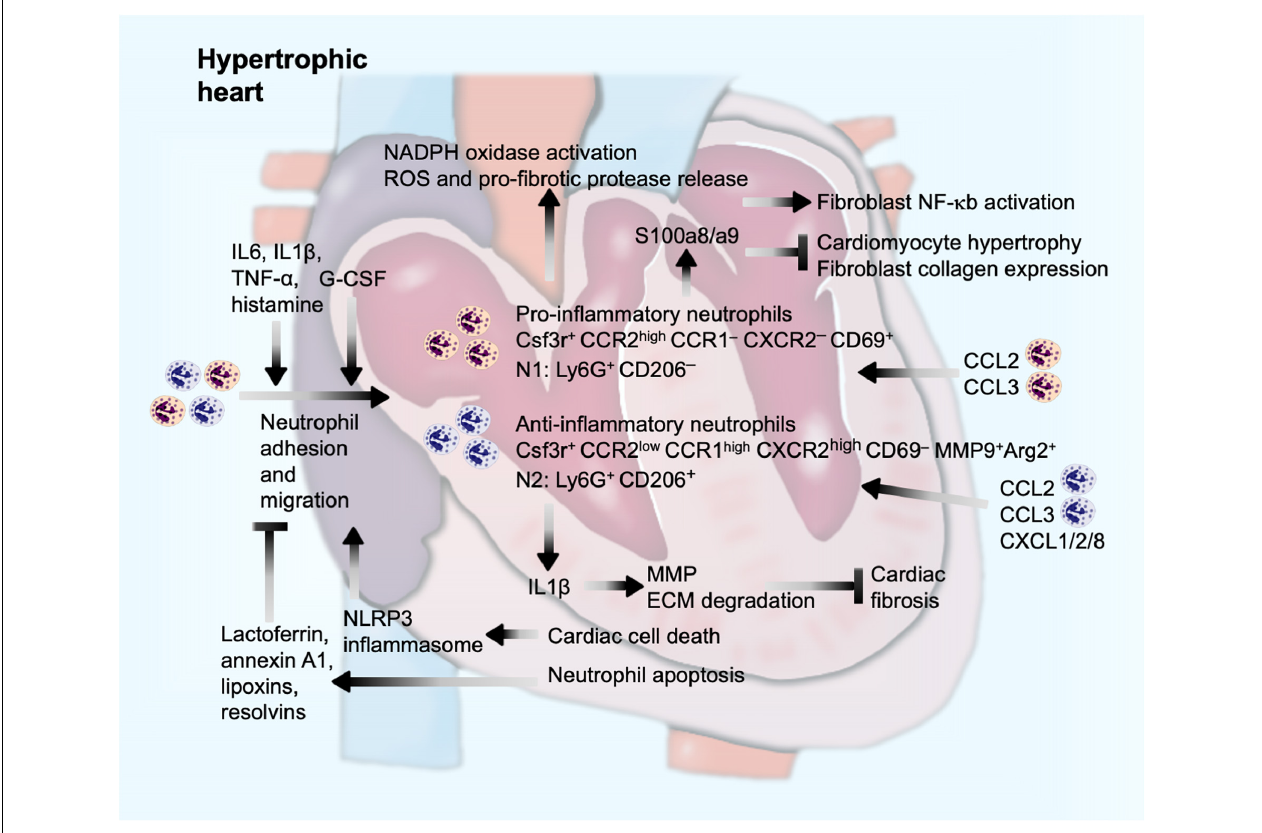
FIGURE 4 | Neutrophil function in pressure overload-induced cardiac hypertrophy and fibrosis. Cardiac injury and inflammatory molecules promote neutrophil adhesion and migration into the heart, a process that can be enhanced by G-CSF and neutrophil-derived Wnt5a, but blocked by lactoferrin and anti-inflammatory lipid-mediators from apoptotic cardiac cells or neutrophils. Inside the heart, neutrophils produce IL1 β to promote ECM proteolysis and reduce cardiac fibrosis, induce activation of NADPH oxidase and release of ROS and pro-fibrotic proteases, or produce S100a8/a9 to induce fibroblast inflammatory activation or to block cardiomyocyte hypertrophy or fibroblast procollagen